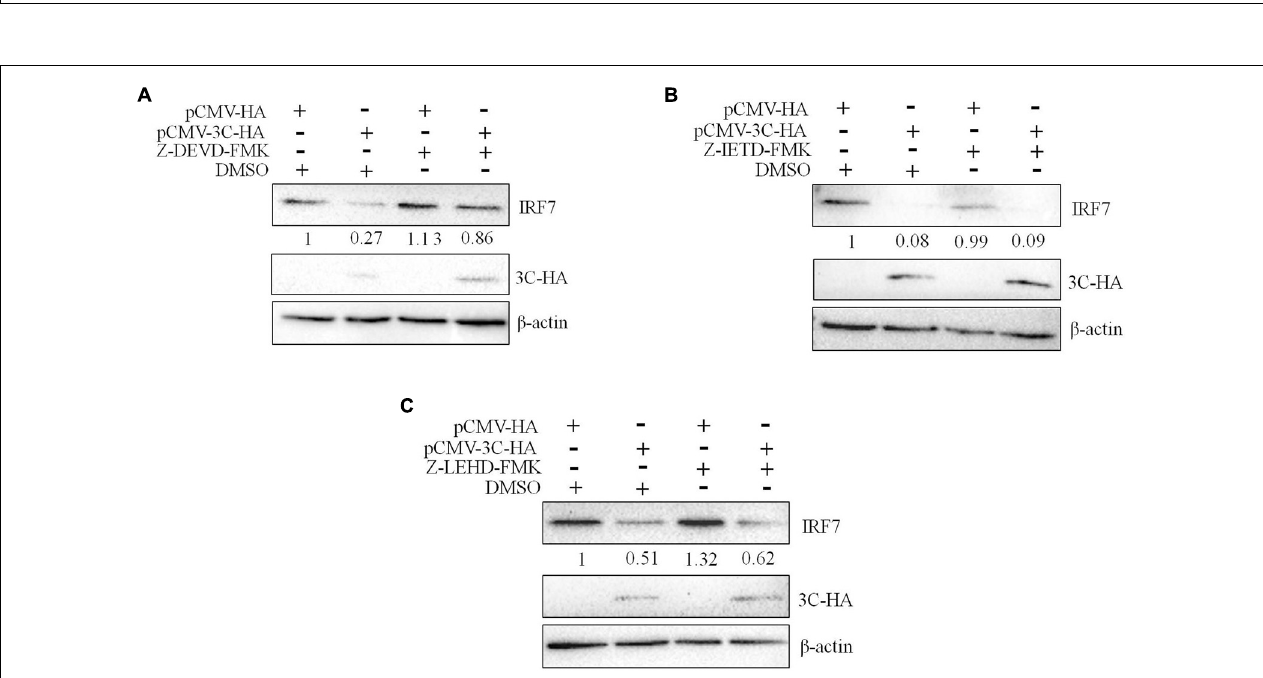
FIGURE 8 | The degradation of IRF7 induced by the 3C protein depends on caspase 3. A total of 1.6 µ g of pCMV-3C-HA and 1.6 µ g of pCMV-HA were transfected into DEFs. Twenty-four hours after transfection, the caspase 3 inhibitor Z-DEVD-FMK (20 µ M), caspase 8 inhibitor Z-IETD-FMK (30 µ M), and caspase 9 inhibitor Z-LEHD-FMK (20 µ M) were added to the cell culture medium. After 12 h of treatment, cell samples were collected and subjected to immunoblotting experiments to detect the endogenous IRF7 expression level in the presence or absence of the inhibitors. (A) The effect of Z-DEVD-FMK on IRF7 degradation. (B) The effect of Z-IETD-FMK on IRF7 degradation. (C) The effect of Z-LEHD-FMK on IRF7 degradation.